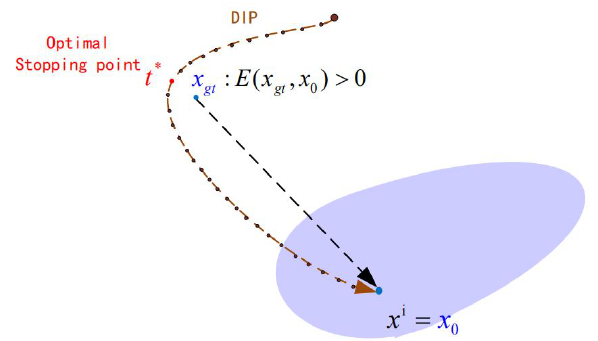
Figure 2. Image space visualization of image denoising using deep image